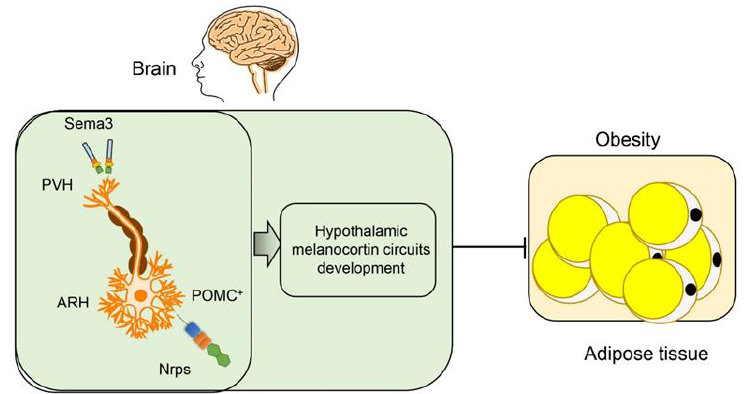
Figure 3. Semaphorins in the hypothalamic regulation of obesity. Sema3 family members are expressed in the hypothalamic paraventricular nucleus of the hypothalamus (PVH), and their receptors neuropilins (Nrps) and plexins are expressed on proopiomelanocortin (POMC + ) neurons in the arcuate nucleus of the hypothalamus (ARH). The Sema3-Nrp axis helps the projections of POMC neurons toward the PVH and the development of hypothalamic melanocortin circuits, which inhibits obesity.